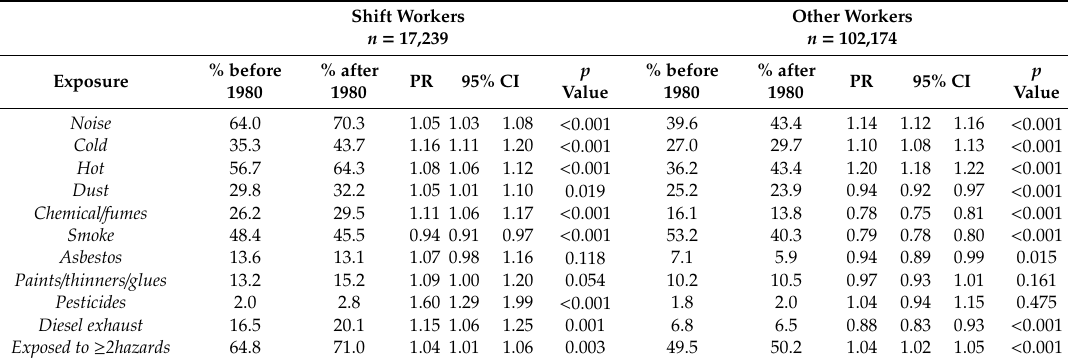
Table 2. Prevalence ratio of workplace hazards among shift workers compared to other workers (reference). Table 3. Prevalence ratio of workplace hazards after 1980 compared to before 1980 (reference).